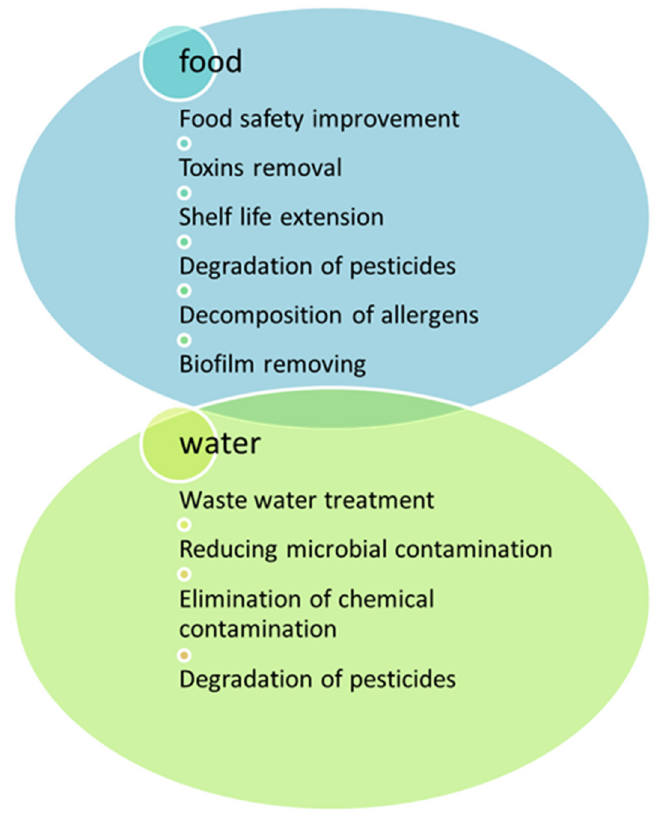
Figure 3. Application of cold plasma in food and water